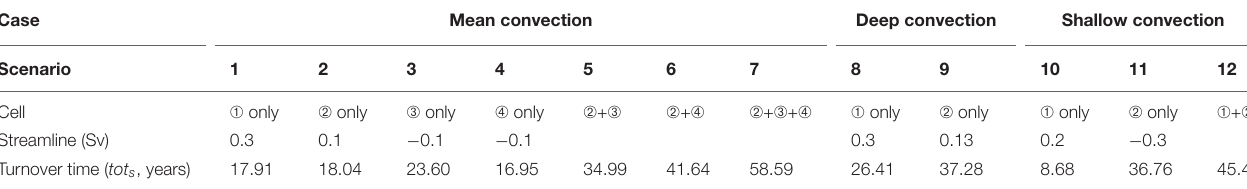
Figure 5 . The resulting tot s s for the shallow convection case were 8.68 years for cell (cid:192) , 36.76 years for cell (cid:193) , and 45.44 years